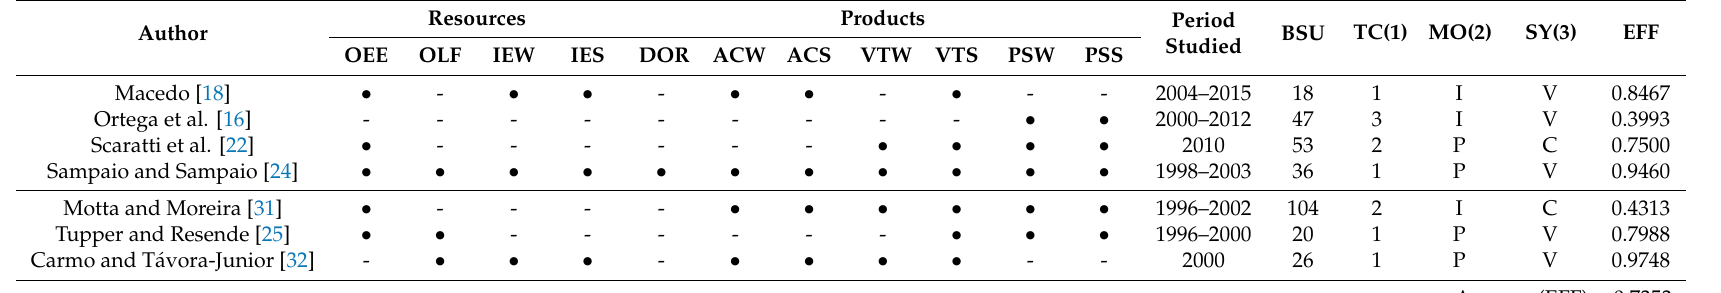
Table 1. Variables used in the literature for sanitation e ffi ciency models applied to DEA used in